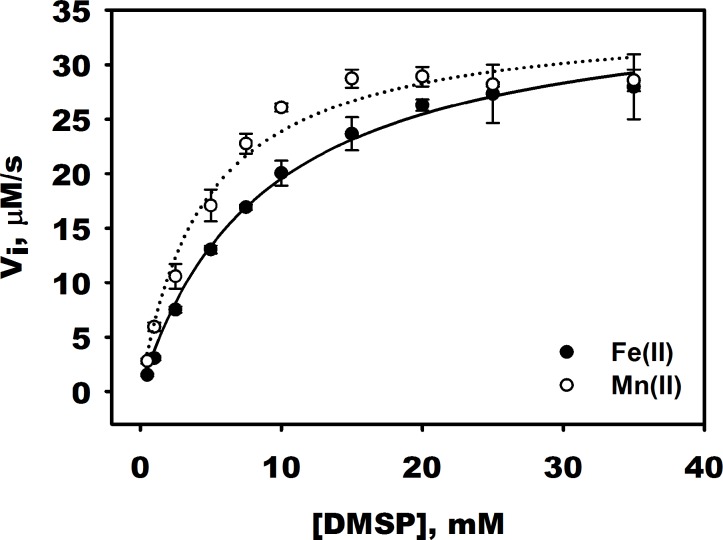
Dependence of initial velocity (Vi) of DddW catalyzed lyase reaction on DMSP concentrations in the presence of Fe(II) and Mn(II).Apo-DddW (2 μM) was mixed with an equimolar amount of Fe(NH4)2(SO4)2 and 300μM MnCl2. To this reaction mixture, varying concentrations (0.5–35 mM) of DMSP was added. The reactions were monitored at 205 nm. The data were fit to the Michaelis-Menten equation. The kinetic parameters are as follows. With Fe(II): Vmax = 36.50 ± 1.27 μM/s; kcat = 18.25 s-1; K
m = 8.68 ± 0.73 mM; k
cat/K
m = 2.10 x 103 M-1s-1; With Mn(II): Vmax = 34.66 ± 1.64 μM/s; kcat = 17.33 s-1; K
m = 4.50 ± 0.75 mM; k
cat/K
m = 3.85x103 M-1s-1.